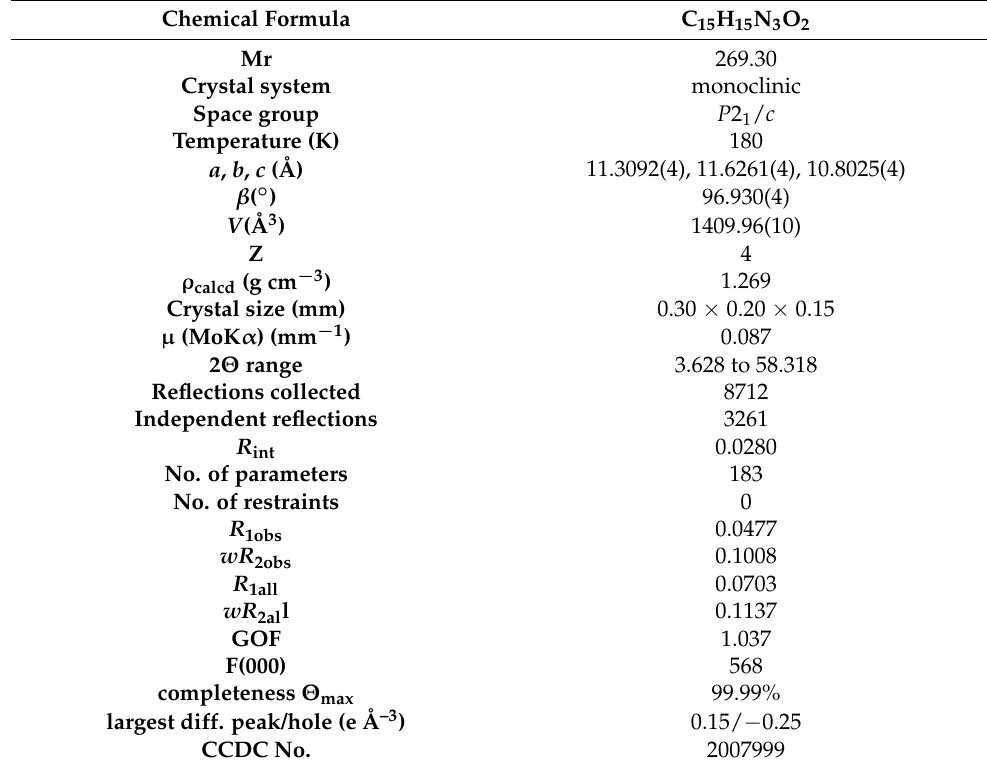
Table 1. Crystal data for compound